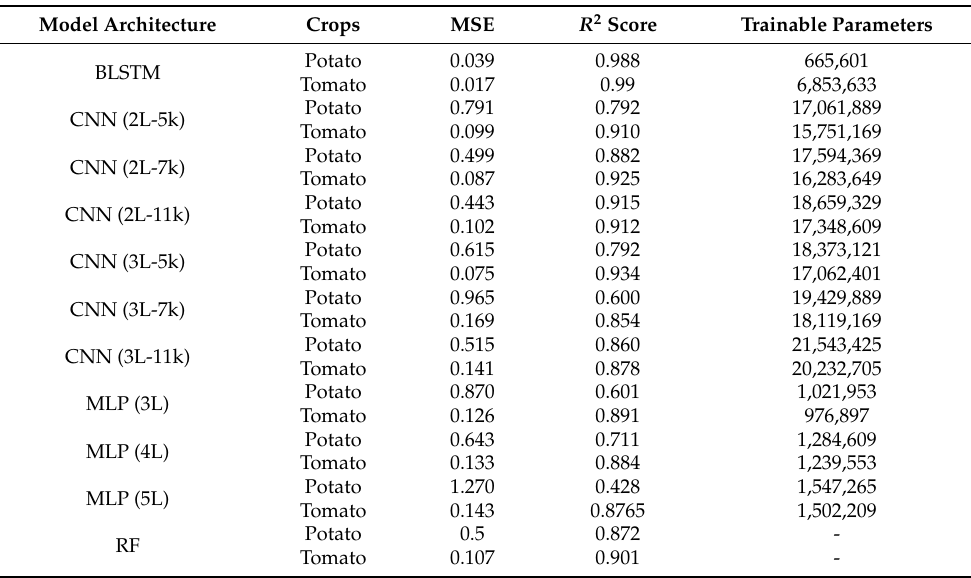
Table 8. Performance of the models on the test set. L shows the number of layers, and K shows the kernel